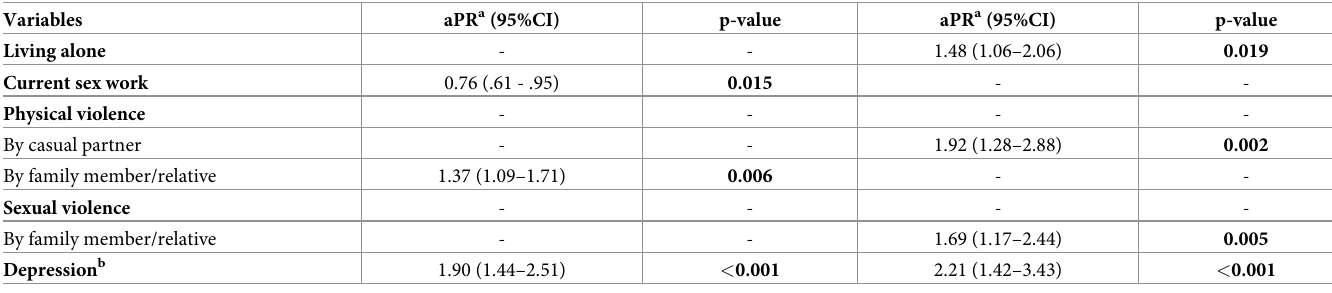
Table 4. Final model of predictors of lifetime suicidal ideation and attempted suicide among trans women in Rio de Janeiro, Brazil, 2015–2016.